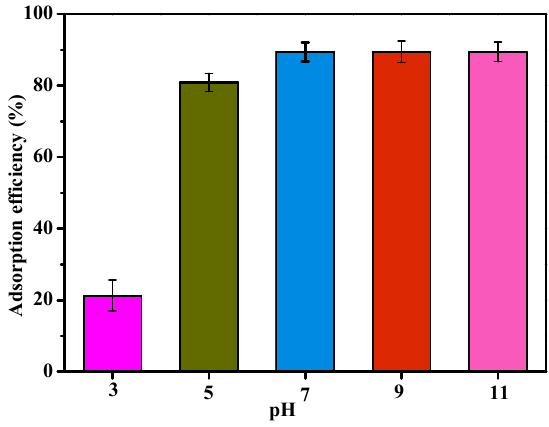
Figure 8. The adsorption efficiency of MSA-AC2 at different pH values.